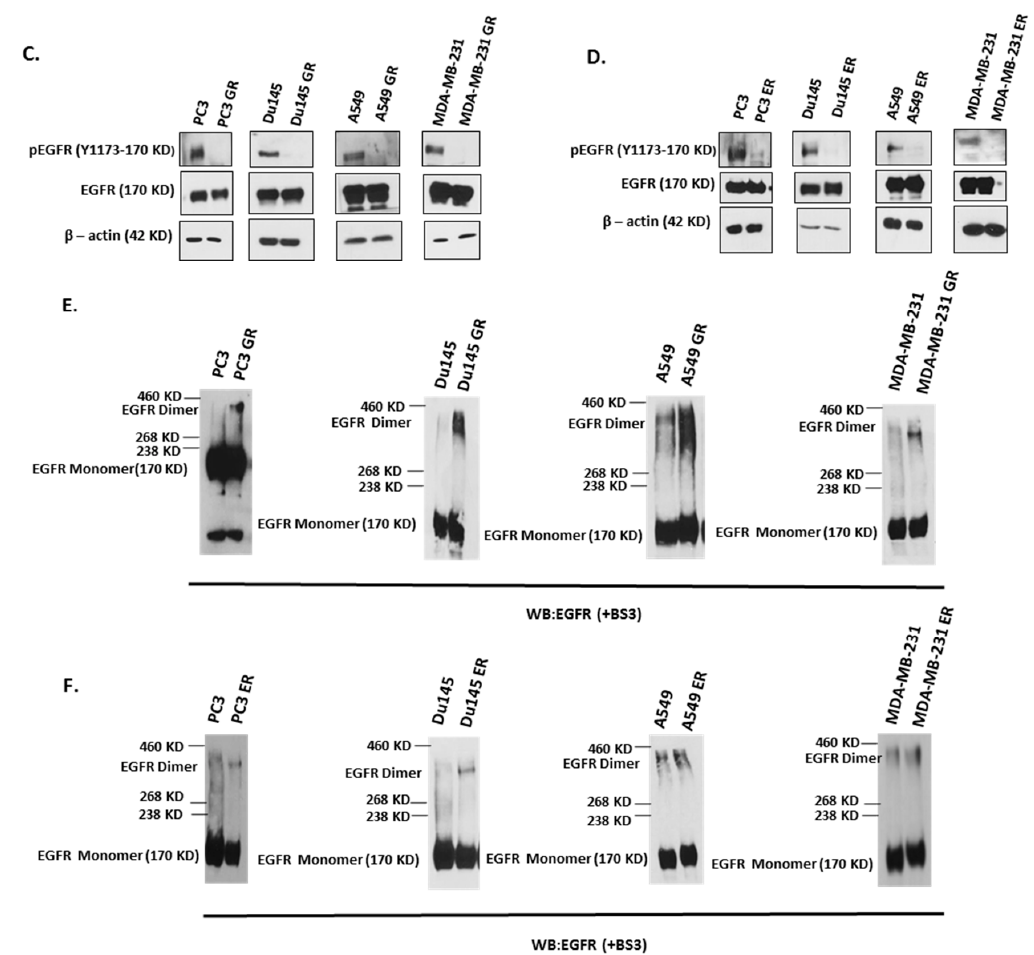
Figure 2. Increase in membrane-tethered EGFR quasi-dimers in TKI-resistant cells. ( A ) Evaluation of efficacy of wild-type EGFR (wt-EGFR)-positive cells to TKI treatments. EGFR-positive cell types were seeded on 6-well plates. Once the cells were 80% confluent, the cells were treated with increasing doses (lowest dosage was 0.5 µM and highest dosage was 10 µM) of gefitinib and erlotinib for 72 h in serum-free media. Equal volumes of cell suspension were incubated with 0.4% trypan blue to obtain 1:2 dilutions. Cells were counted using hemocytometer and cell viability was calculated. Results were triplicated ± SD and were pooled into treatment groups. One-way analysis of variance (ANOVA) and Tukey’s multiple comparison test were used for statistical analyses, *** p < 0.001, **** p < 0.0001; ( B ) Survival of gefitinib-resistant (GR) and erlotinib-resistant (ER) cells not affected by TKI treatments. All the GR cells (PC3 GR, PC3 ER, Du145 GR, Du145 ER, A549 GR) were treated with increasing dosage of gefitinib and the ER cells (A549 ER, MDA-MB-231 GR, MDA-MB-231 ER) were treated with increasing dosages of erlotinib for 72 h and cell proliferation was measured using MTT (Promega). Percent viable cells were calculated for each dosage against the vehicle (0.5% DMSO). Data are mean ± SEM with n = 3; ( C , D ) comparison of EGFR’s kinase activity (pEGFR) in chronically-treated GR and ER cells versus the non-treated parental cells; ( E , F ) TKI-induced membrane-tethered EGFR dimers persist in GR and ER cells. The degree of dimerization were analyzed in both GR and ER cells compared to the parental cells using membrane crosslinking agent BS3. The cell lysates were resolved on SDS-PAGE gel in reducing conditions followed by western